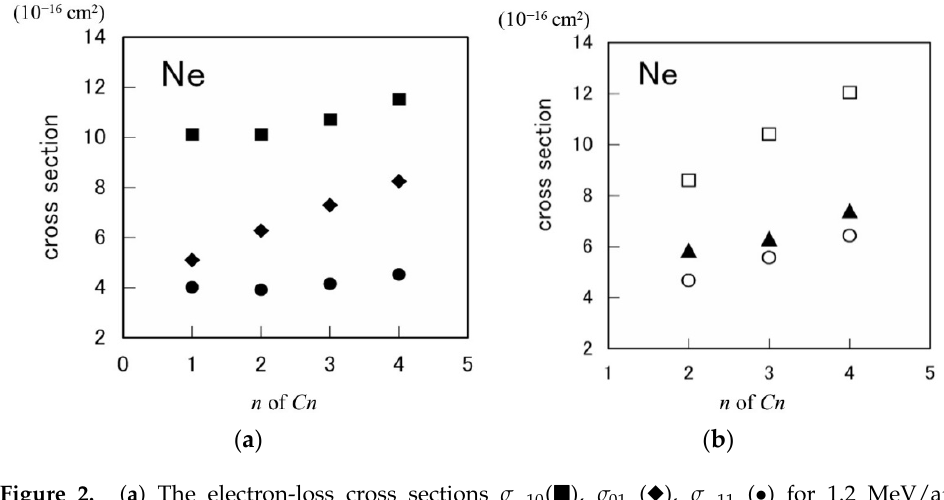
( a ) The electron-loss cross sections σ − 10 ( (cid:4) ), σ 01 ( (cid:117) ), σ − 11 ( • ) for 1.2 MeV/atom C n ( n = 1 − 4 ) and ( b ) the destruction cross sections σ 1 d ( (cid:3) ), σ − 1 d ( (cid:78) ), σ 0 d ( ) for 1.2 MeV/atom C n ( n = 2 − 4 ) clusters in a linear chain in collision with Ne atom [38].